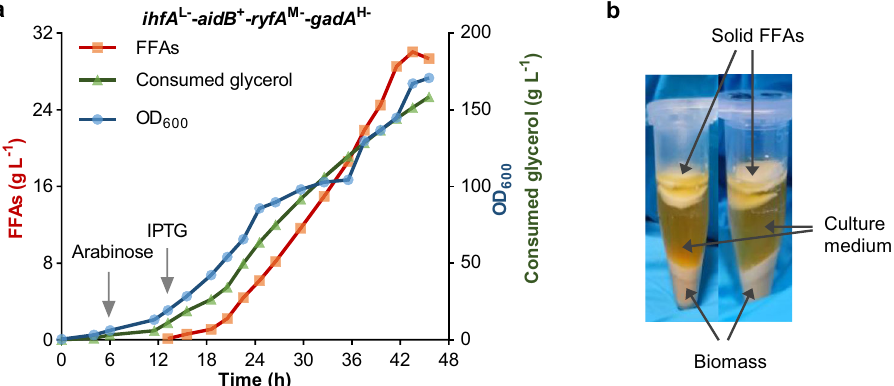
Fig. 8 Fed-batch fermentation of the ihfA L − - aidB + - ryfA M − - gadA H − strain for FFAs production in a 5 L bioreactor. a Time courses of cell growth, glycerol consumption, and FFAs production of the ihfA L − - aidB + - ryfA M − - gadA H − strain during fed-batch fermentation (Batch 1). The result of a duplicate fermentation (Batch 2) is shown in Supplementary Fig. 9b, exhibiting a similar titer and productivity. b Solid FFAs layer after centrifugation. After fermentation, 1 mL of sample was picked up and centrifuged at 5000 × g for 15 min. Source data underlying ( a ) are provided as a Source Data fi